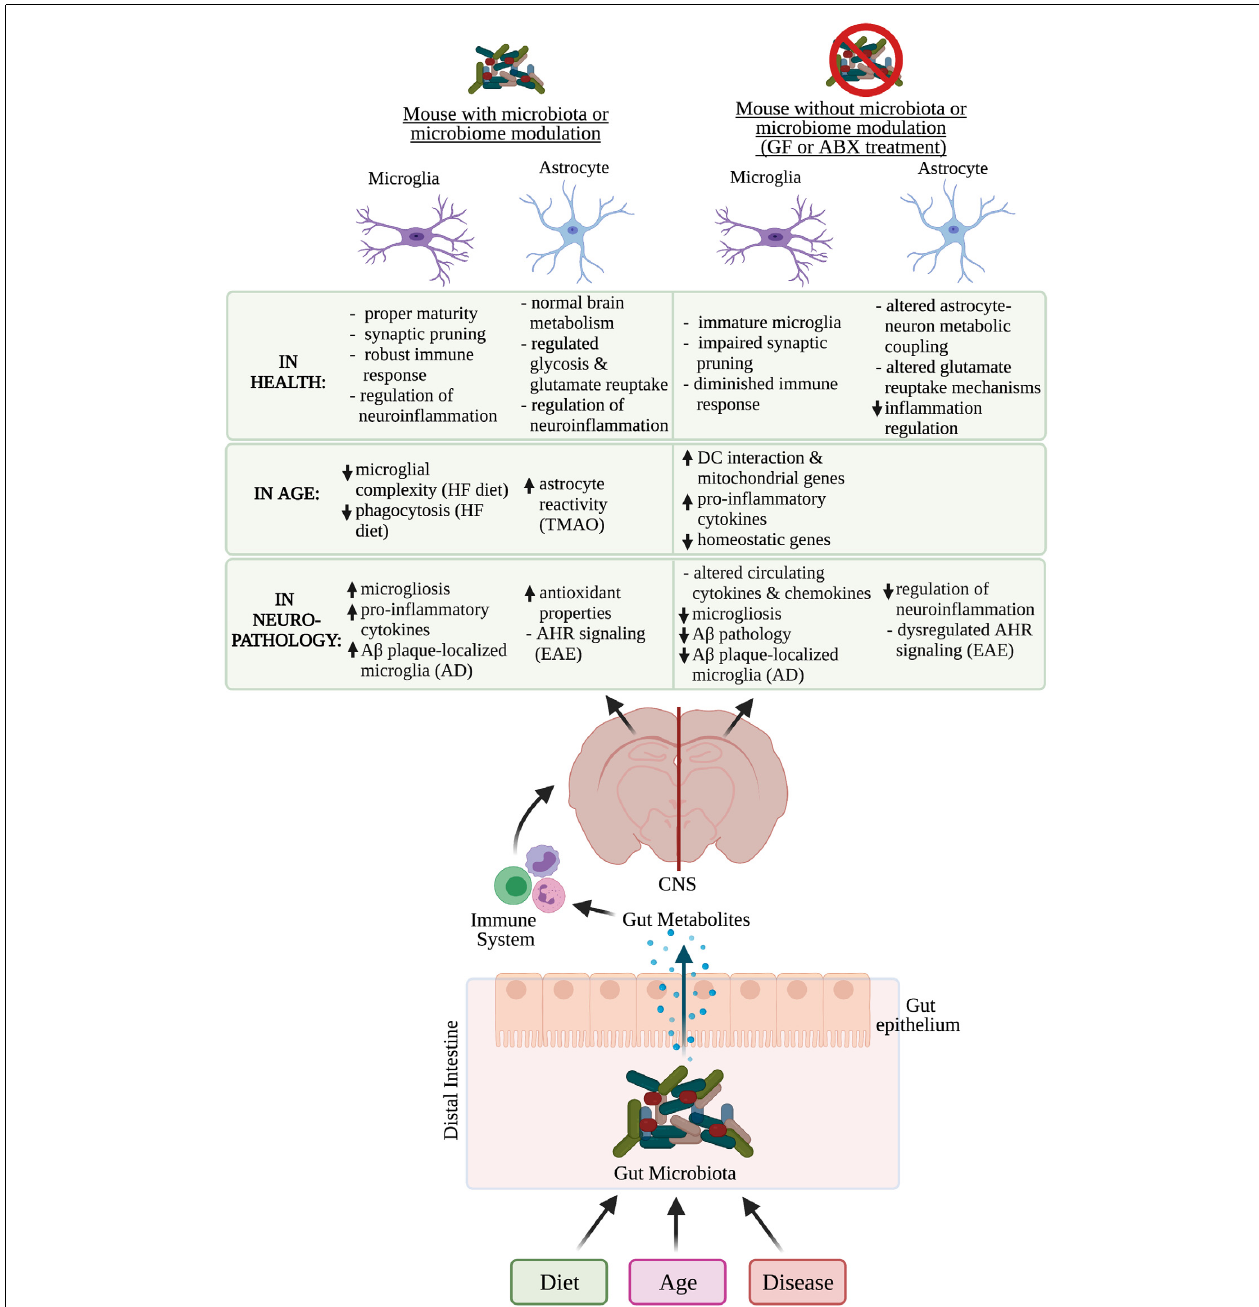
FIGURE 2 | Microbiome influence on microglia and astrocyte function in health, age, and neuropathology. Multiple factors affect an individual’s microbiome composition including diet, age, and disease. In the distal intestine, gut metabolites can cross the gut epithelium and modulate the immune system, which can influence the function of microglia and astrocytes in health, age, and neurodegenerative diseases. Functions of microglia and astrocytes that are altered in mice who have had their microbiome altered, contain a microbiome or lack thereof have been identified. A β , amyloid- β ; GF, germ-free; ABX, antibiotic; AD, Alzheimer’s disease; EAE, experimental autoimmune encephalomyelitis; CNS, central nervous system; DC, dendritic cell; HF, high-fat; TMAO, trimethylamine N-oxide; AHR, aryl hydrocarbon receptor. *Created with Biorender.com.